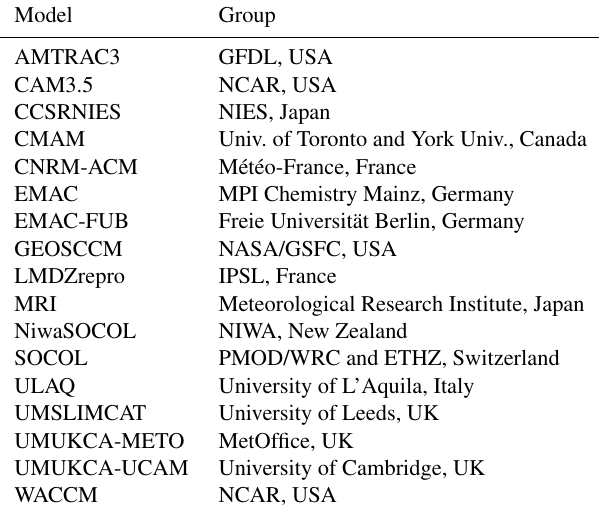
Table 1. List of participating CCMs.